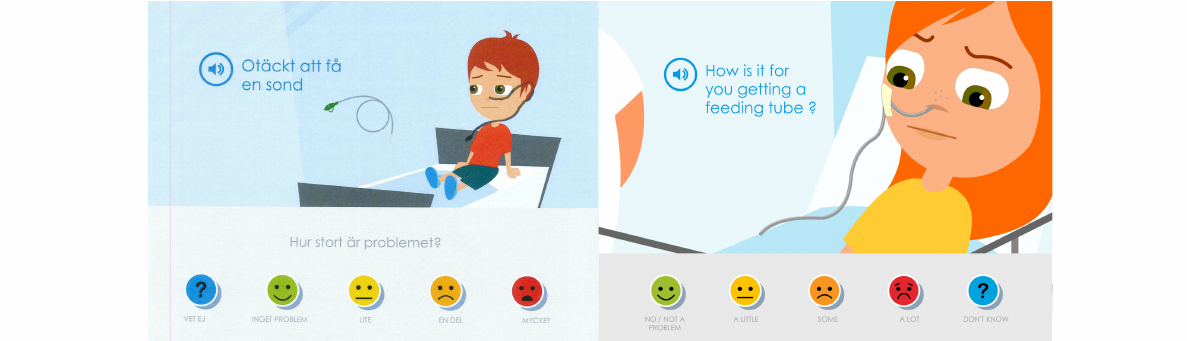
Figure 8. The children wanted the object in the pictures to be integrated with the avatar in the animation and not be “in the air” beside the avatar. Left: an example of what a child drew on a screenshot; Right: the final version in Sisom 2.